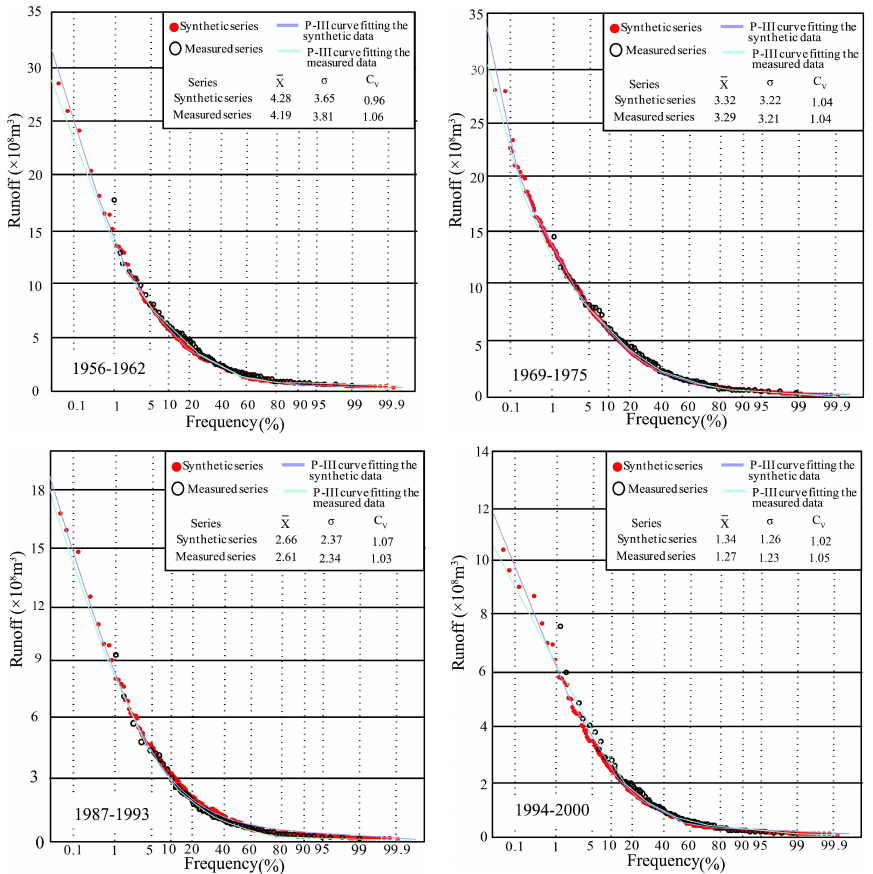
( j ) Figure 14. Scatter diagram ( a – d ) and boxplots ( f – i ) of the synthetic series and measured series in four segments at Gaojiabao gauge; ( e ) a scatter diagram of all the synthetic data and the whole original